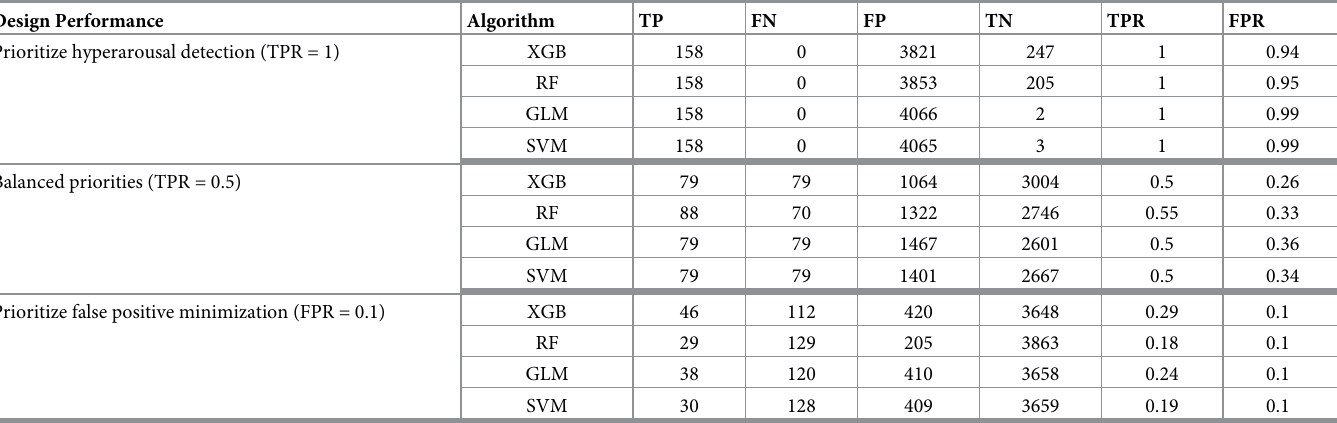
Table 3. Confusion matrices for all models at different probability cut